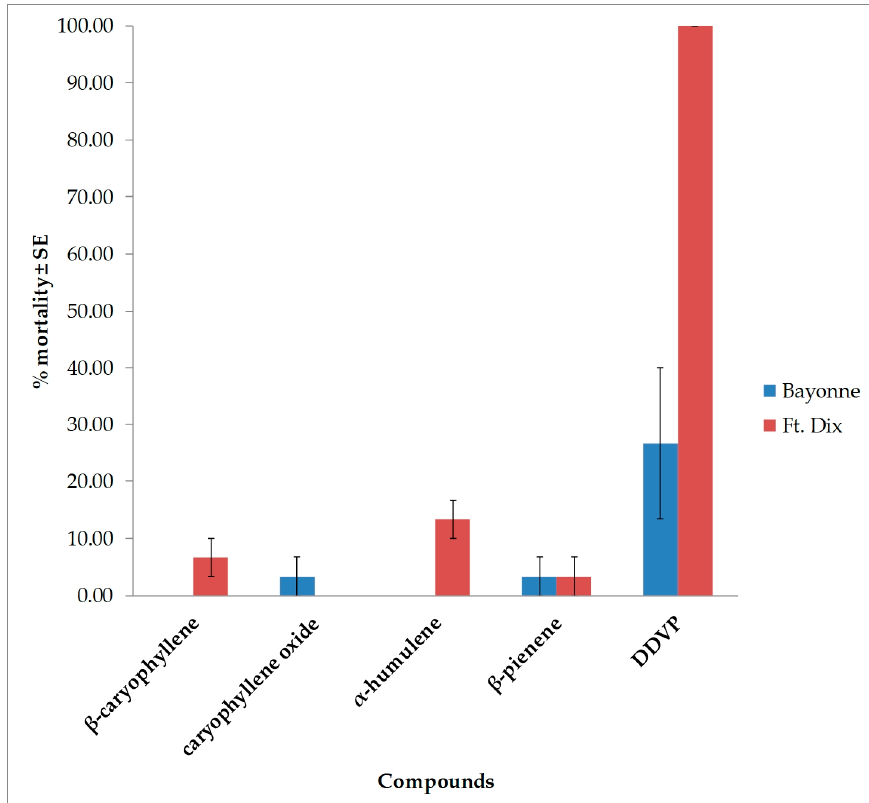
Figure 7. Mean (±SE) mortality produced by four compounds in two strains of bed bug in the vapor toxicity bioassay in 250 µg/125 mL of air. There were three replications per treatment with 10 bugs (adult mixed sex) per replication. The means and standard errors were calculated in f JMP® 10.0.